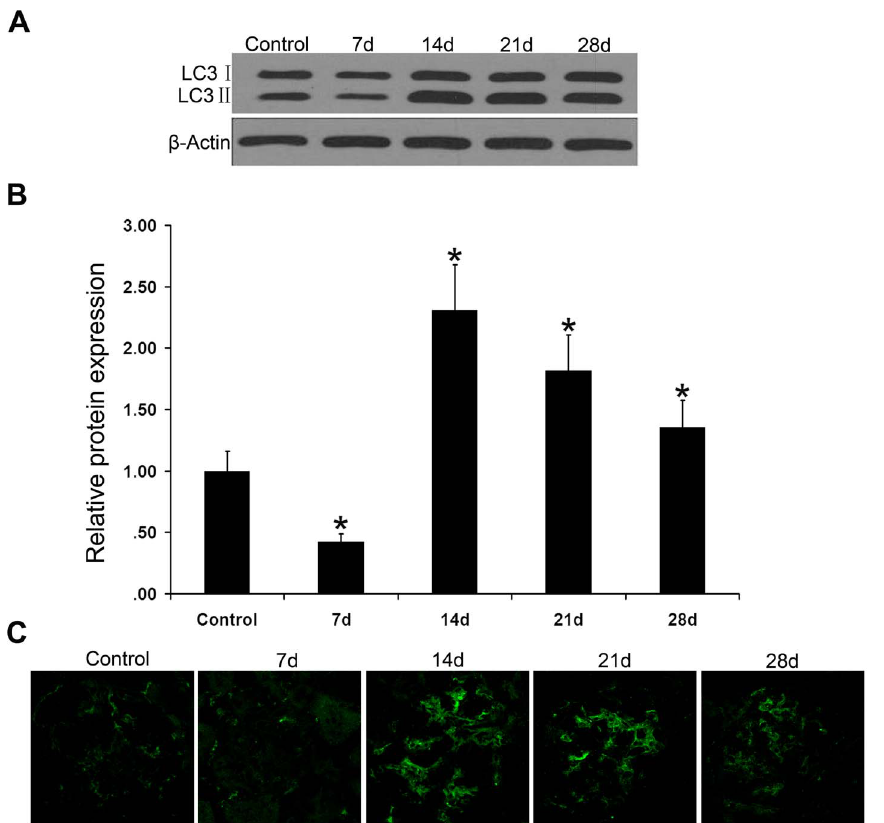
Figure 3. Autophagy level was first decreased and then increased in PHN rat glomeruli. (A–B).Western blot analysis of isolated glomerular protein confirmed the downregulation of LC3 II (an autophagy marker) in the glomeruli from PHN rats on day 7 compared to control rats, indicating decreased autophagy level. From day 14, the expression of LC3 II was upregulated, indicating increased autophagy level, * P , 0.05 vs Control.(C).Confocal microscopic analysis of renal cortex cryosections from PHN rats and controls confirmed the expression of LC3 (green, an autophagy marker), indicating that the autophagy level first decreased and then increased in PHN rat glomeruli compared to that in control rats. Magnification = 6